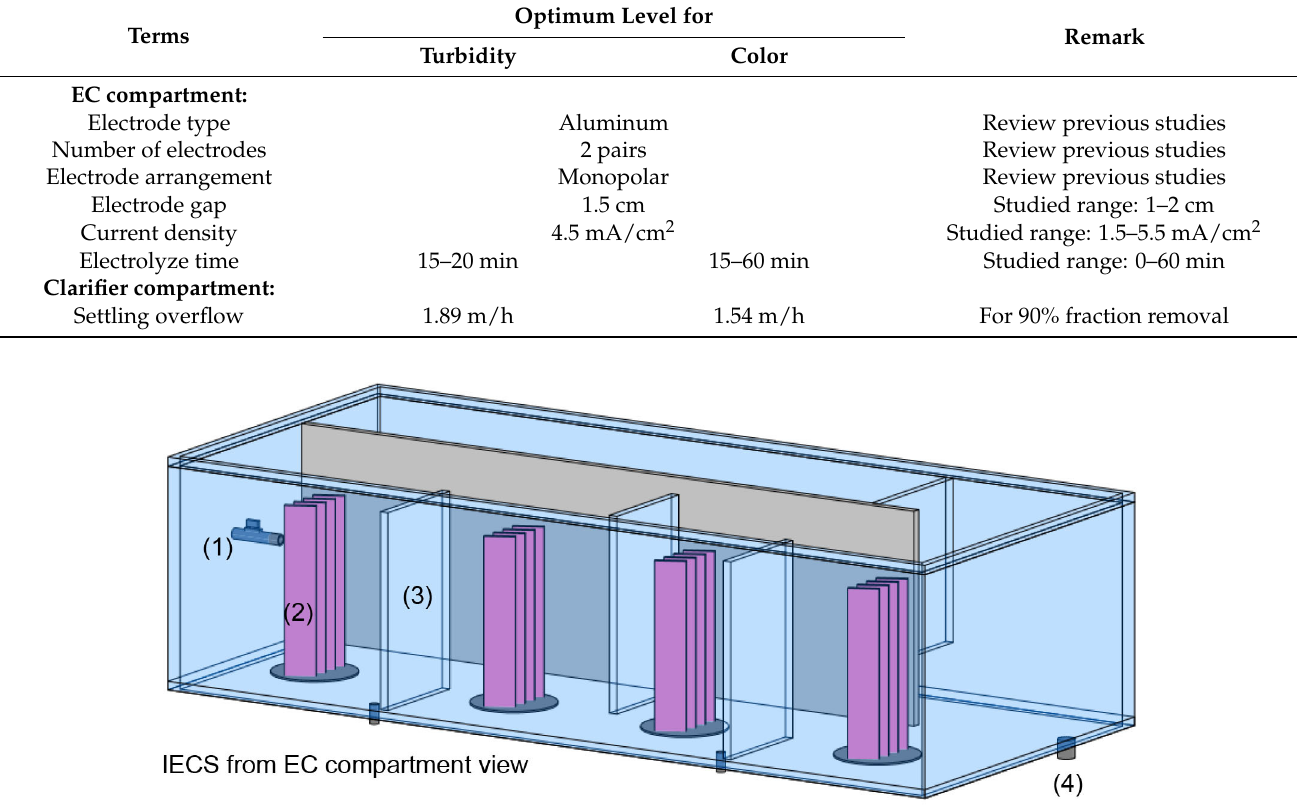
Table 2. Summary the design criteria for each compartment used to design IECS reactor.